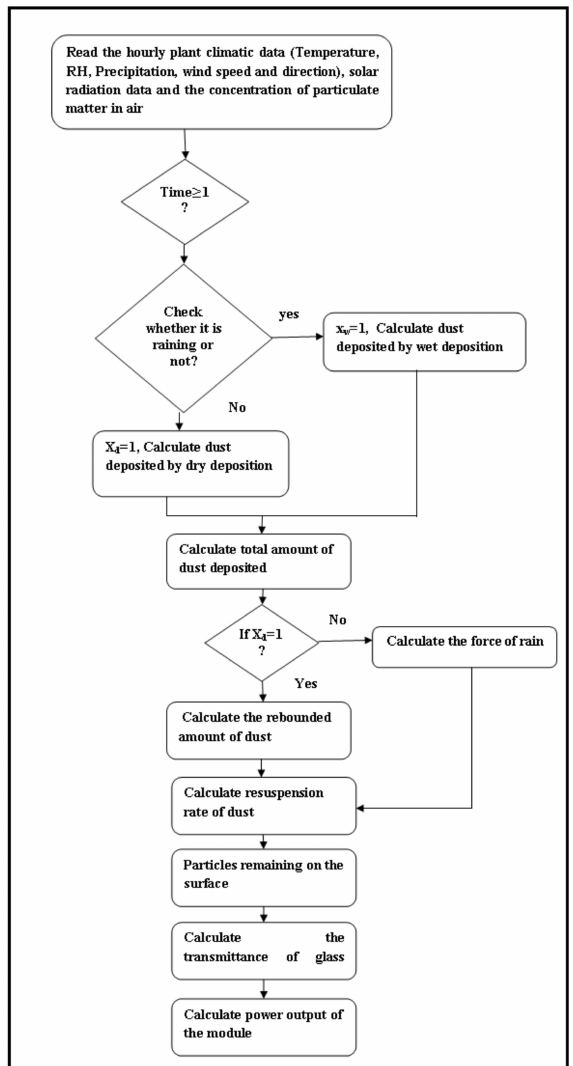
Figure 1. Flowchart of the model for soiling loss